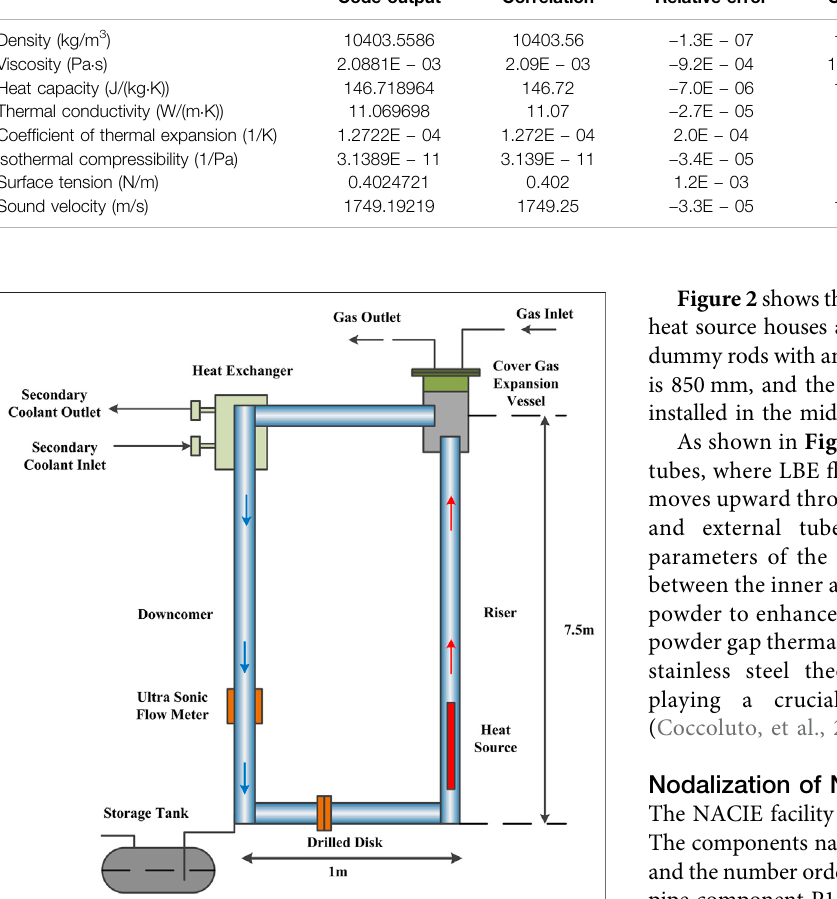
FIGURE 1 | NACIE test facility schematic (Tarantino et al.,